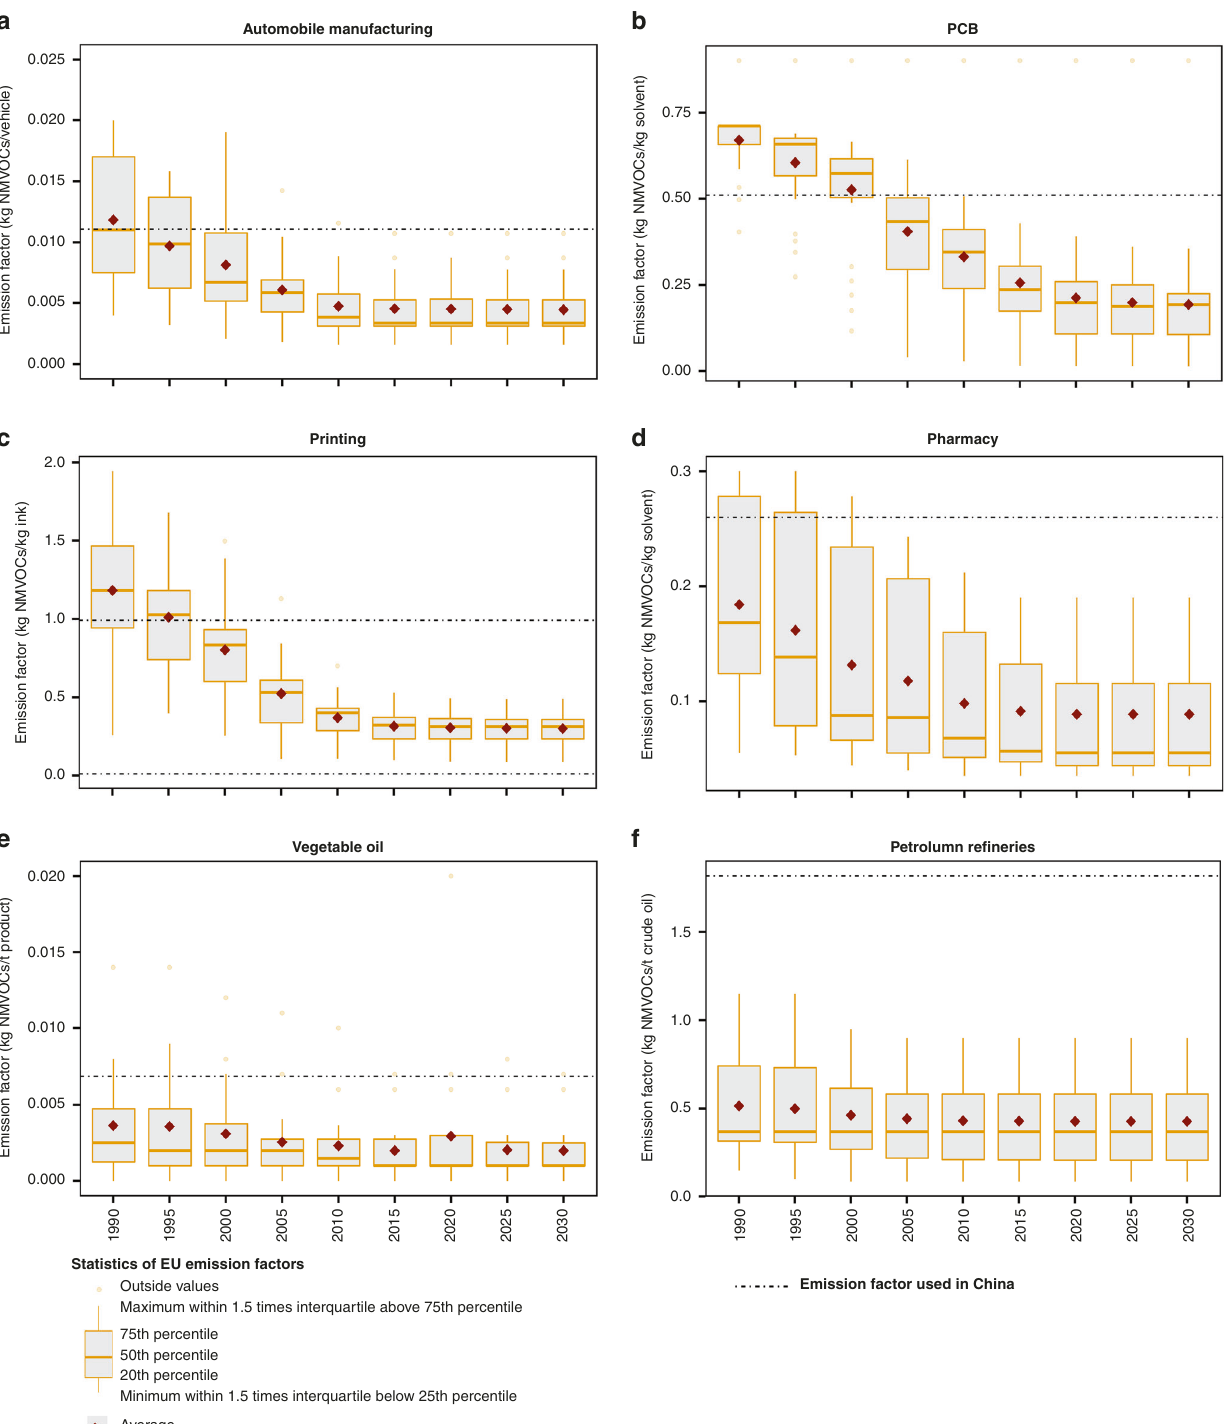
Fig. 4 Gaps of NMVOC emission intensities between China and EU. Boxplots represent the distribution of European levels in every 5 years from 1990 to 2030. The dotted line denotes the level of China in 2013. Intensities of China fall within the range of EU for most sectors, e.g., a automobile manufacturing, b PCB, c printing, d pharmacy and e vegetable oil. For f , petroleum re fi neries, intensities in China were symmetrically higher than in Europe. For evaluation of emission-reduction potentials, relative change in Europe was adopted instead of absolute value. Source data are provided as a Source Data fi